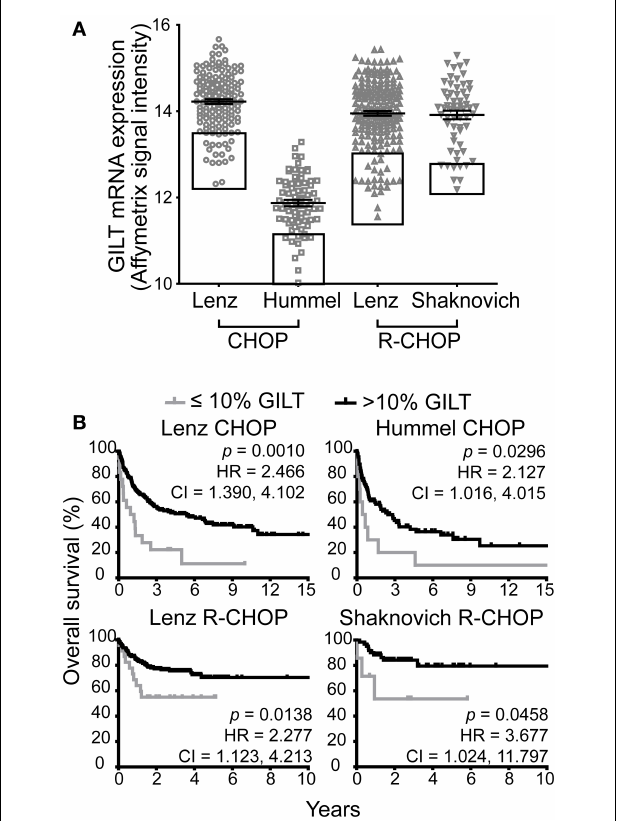
FIGURE 1 | Low GILT gene expression is associated with poor survival in all DBLCL cohorts . (A) The relative mRNA expression of GILT in each patient in the four cohorts. Each symbol represents a single patient.The line and error bars indicate the mean ± SEM.The box indicates the 10% of patients with the lowest GILT expression. (B) Kaplan–Meier survival curves comparing patients with ≤ 10 (gray line) vs. > 10% GILT gene expression (black line).The p -values, hazard ratio (HR), and 95% confidence interval (CI) comparing survival of patients with ≤ 10 and > 10% expression of GILT are indicated for each cohort. Lenz CHOP: n = 18 ≤ 10% GILT, n = 163 > 10% GILT, Hummel CHOP: n = 10 ≤ 10% GILT, n = 92 > 10% GILT, Lenz